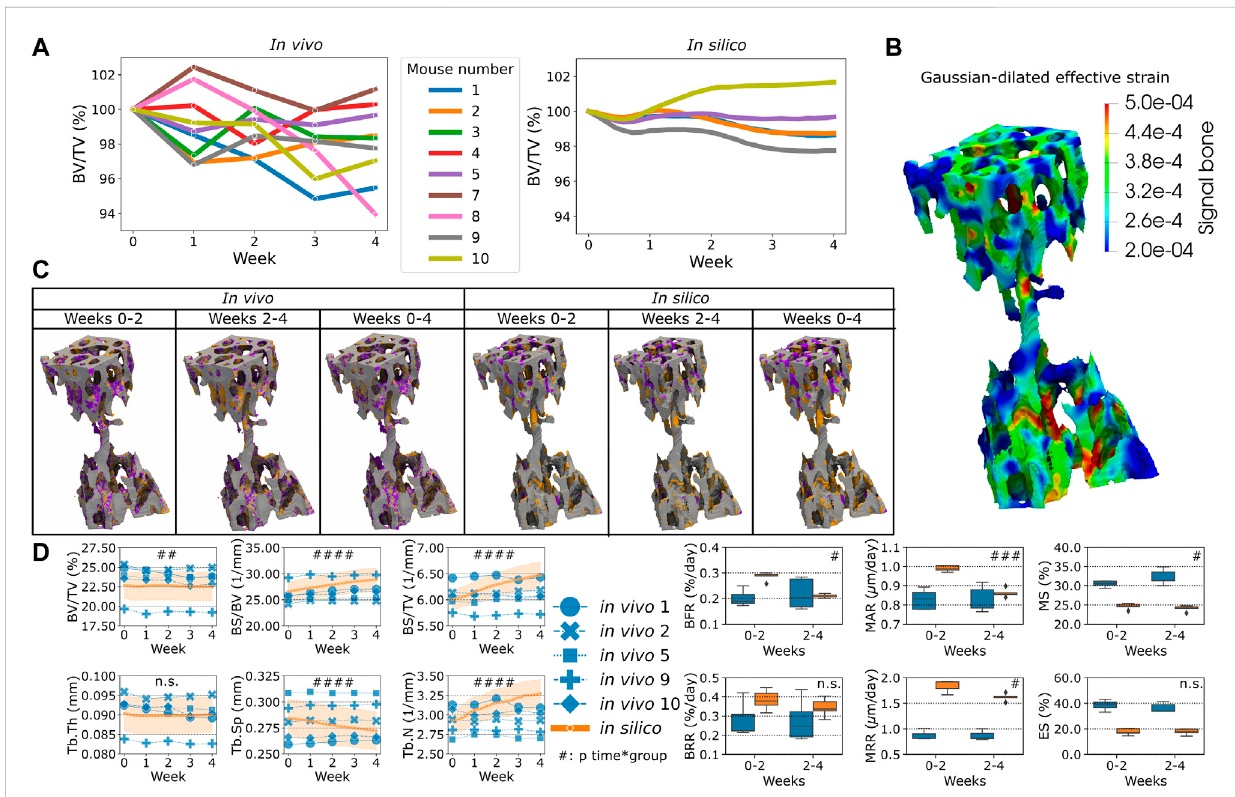
FIGURE 2 The in vivo data and the comparison against the in silico modeling of homeostasis. (A) The normalized bone volume fraction (Norm. BV/TV) for the complete groupofmice invivo (left, n =10)and forthegroupofmiceanalyzed insilico (right, n =5). (B) Mechanical signal inthetrabecularregion forthe representativemouse(number5). (C) Boneformation(orange), quiescence(gray)andresorption(purple)eventsimagesovertime invivo and insilico . (D) Staticanddynamicbonemorphometryvaluesforthe invivo and insilico groups.Intheseplots,onlythesameselectionofmicewasplottedforboth the in vivo and in silico data ( n = 5). (# p < 0.05, ## p < 0.01, ### p < 0.001, #### p < 0.0001 for the interaction time*group determined by two-way